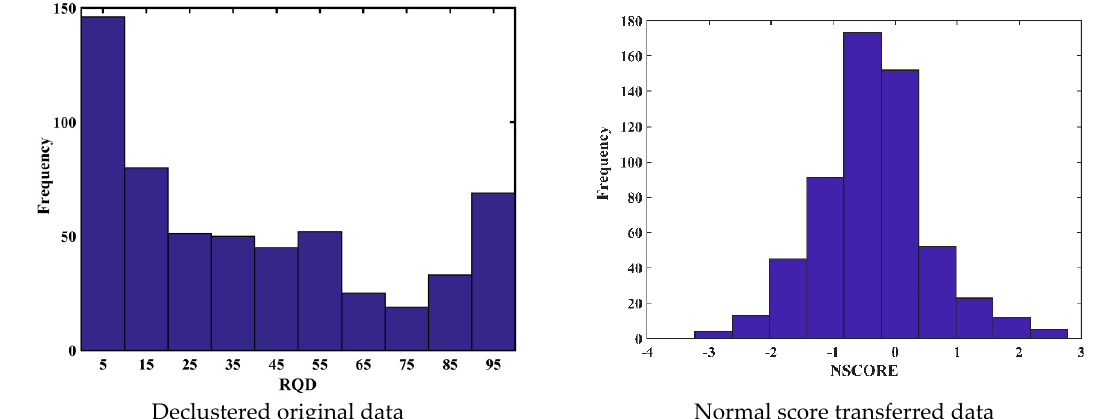
Figure 6. Global distribution of RQD variable (histogram) before and after transformation.